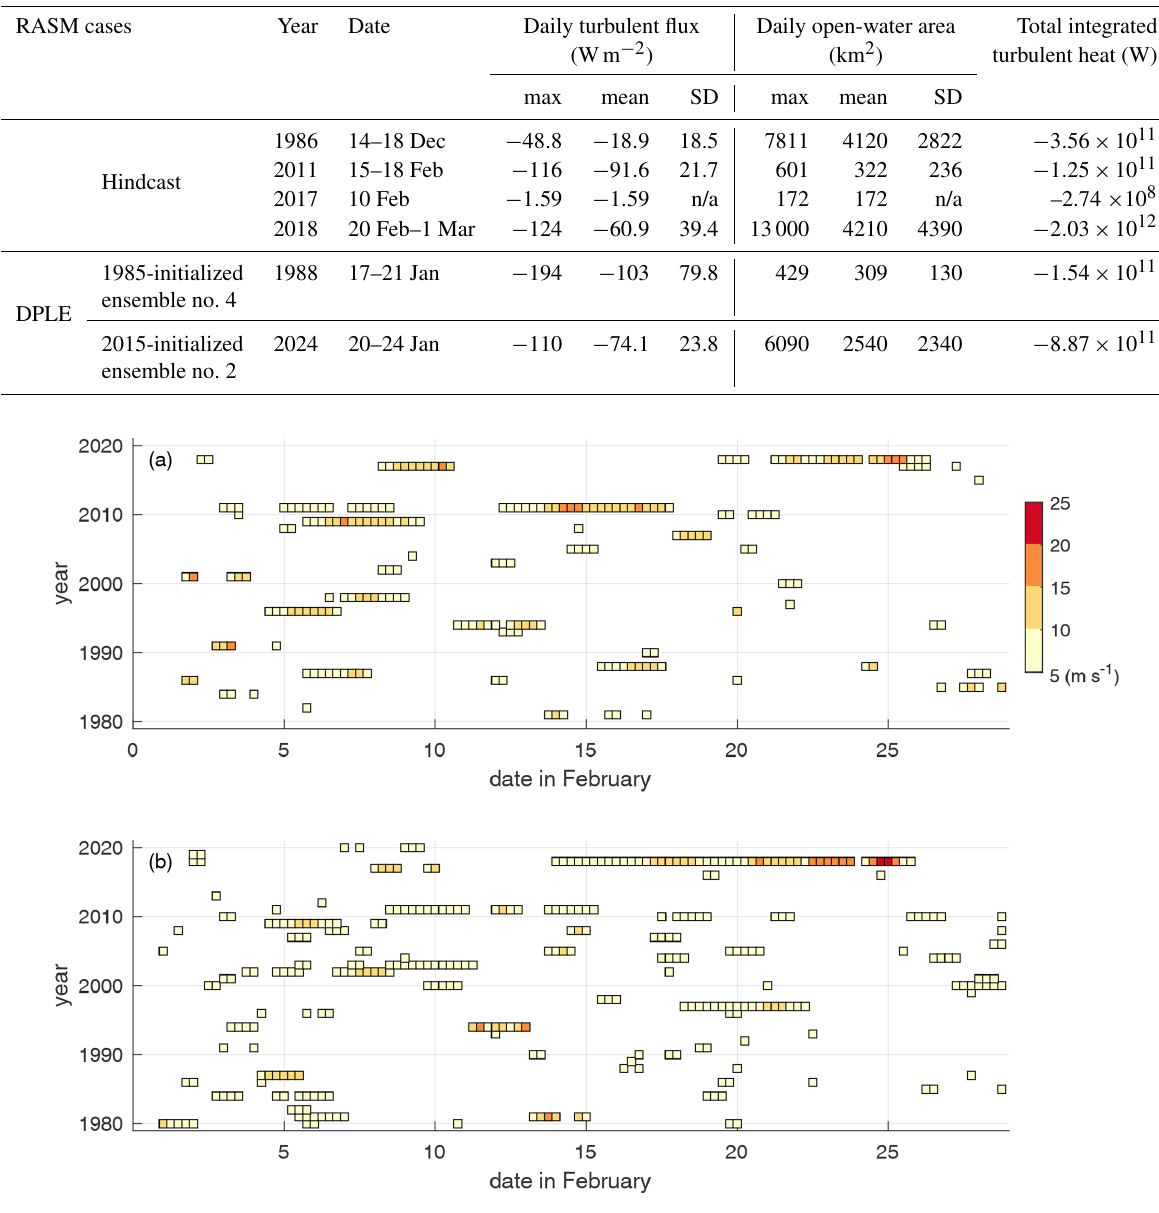
Figure 8. The northward wind component greater than 5ms − 1 from the RASM hindcast simulation during February of 1980–2020 at the nearest grid to (a) Station 04312 (Station Nord) and (b) Station 04301 (Cape Morris Jesup). Each square represents the 6h surface wind, and its color indicates the magnitude of wind